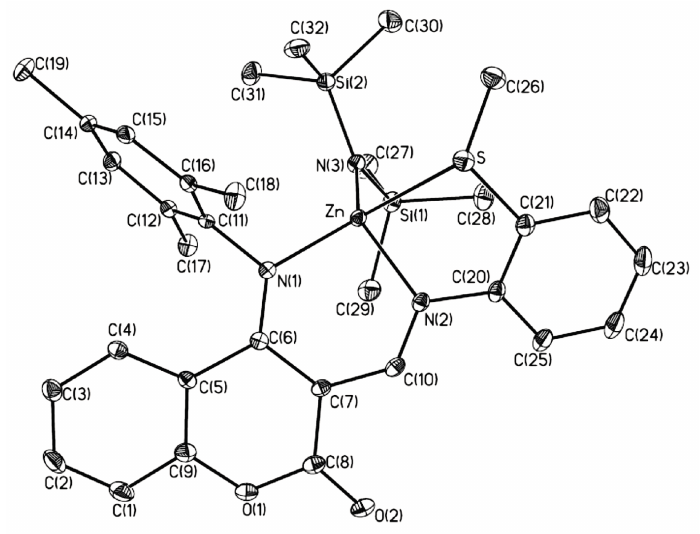
Figure 3. Molecular structure of 7 . Hydrogen atoms omitted for